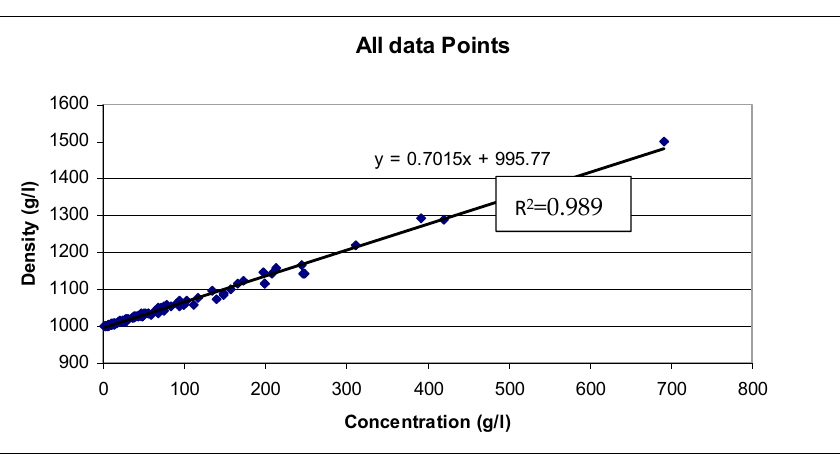
Figure 1. Regression analysis of all data (data source: [3]).